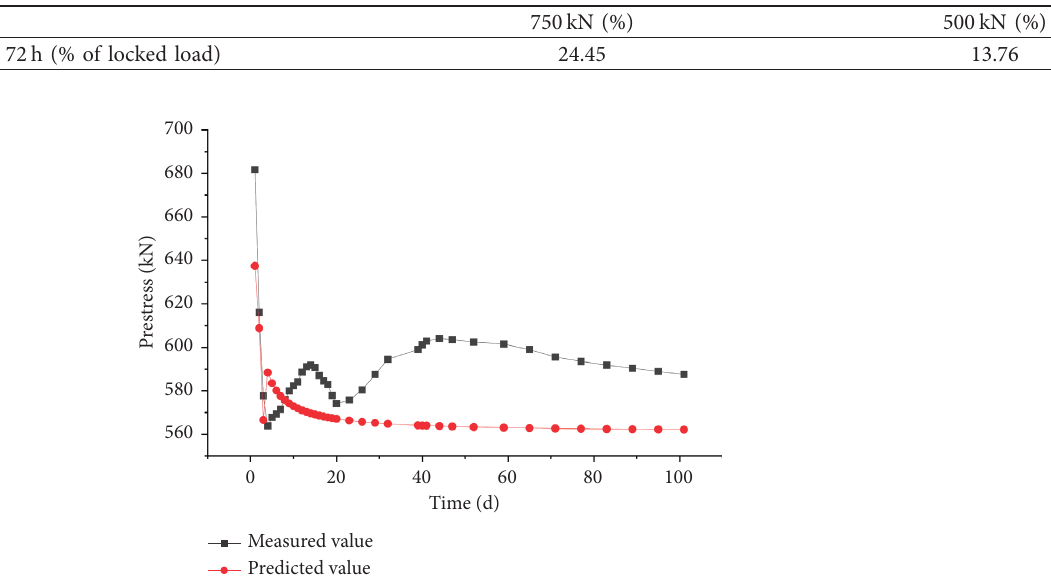
Figure 7: Linear regression of the prestress loss of the first row of 500kN anchor cables at K5 +365 over time. Table 4: Average prestress loss of prestressed anchor cables over 72h.